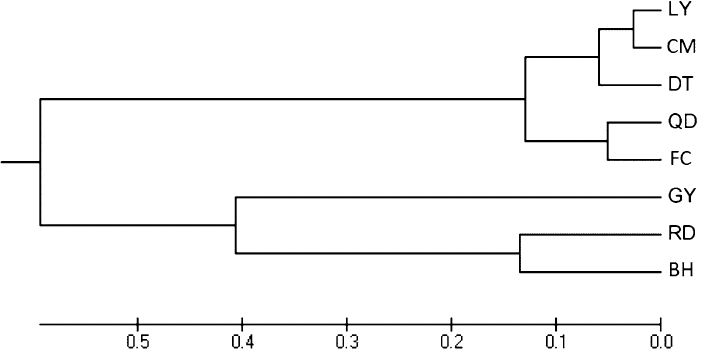
Figure 1. UPGMA clustering tree of L. maculatus populations based on Nei’s distance. LY Lieyu, CM Chongming, DT Dongtou, QD Qingdao, FC Fangcheng, GY Ganyu, RD Rudong, BH Binhai.